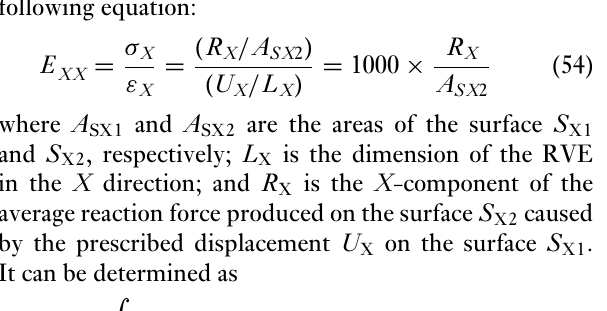
Figure 2 Loading and boundary condition in determining E CC . XX